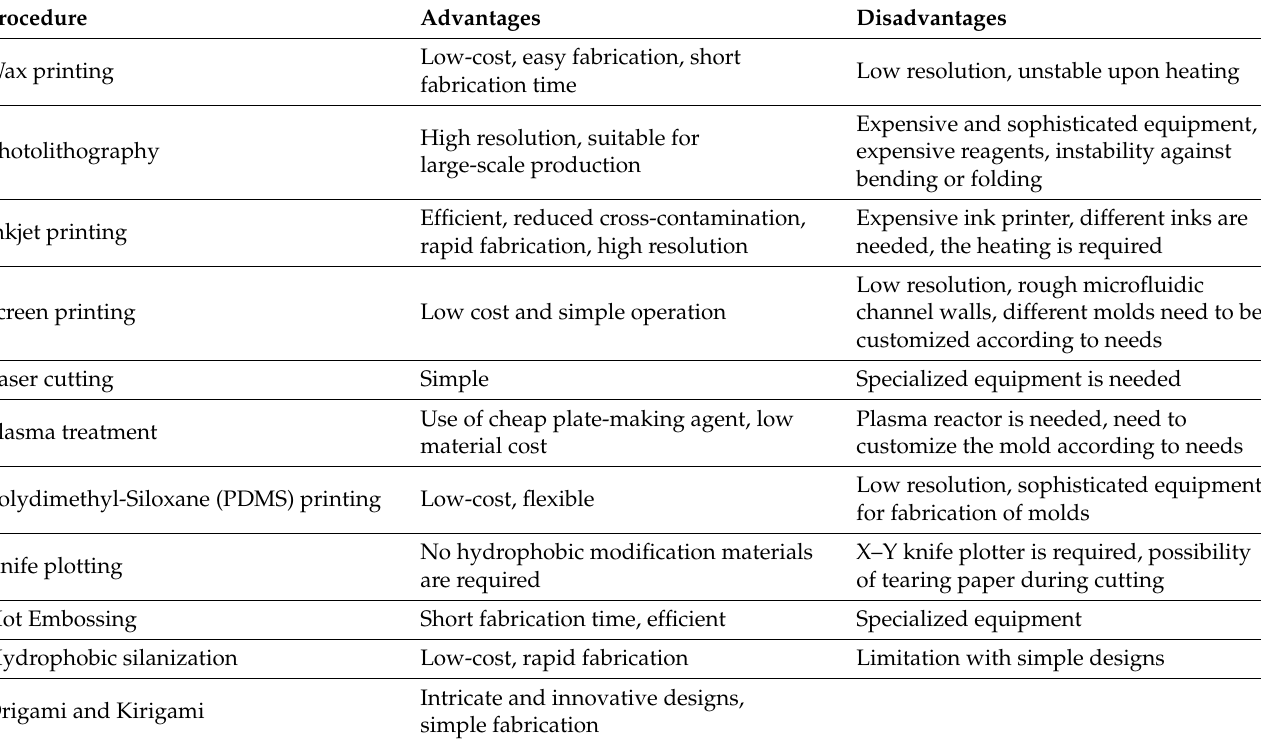
Table 6. Advantages and disadvantages of the main fabrication techniques for paper-based